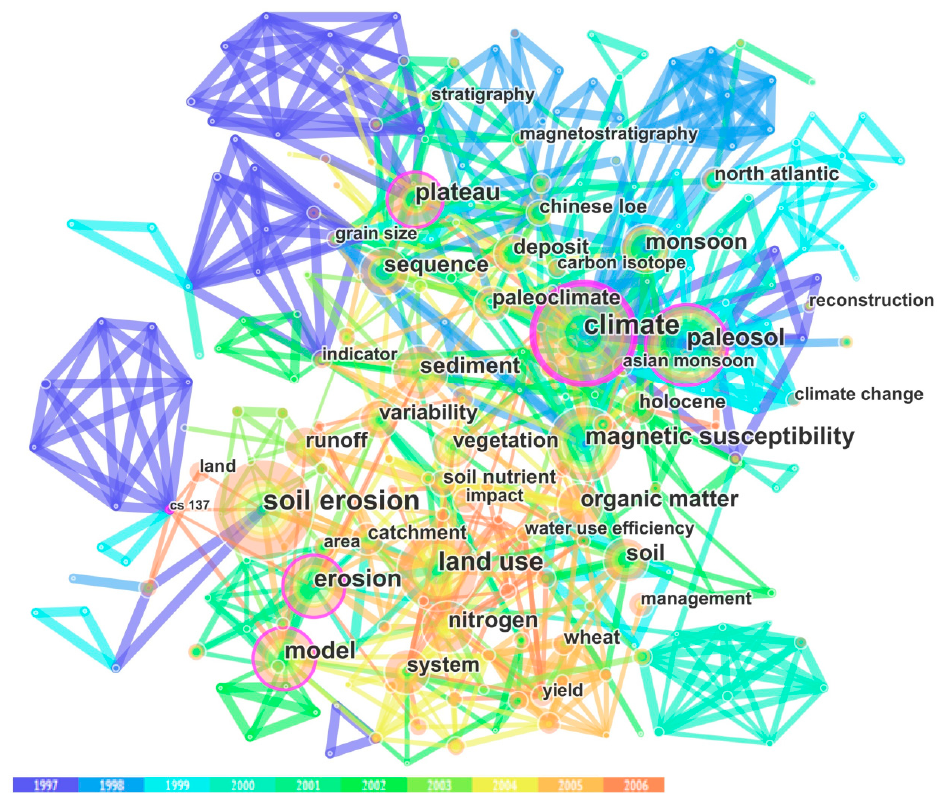
Figure 3. The bibliometric network map of keywords based on SCI literature from 1997–2006. Table 2. Annual distribution of the main research topics of CNKI literature from 1997–2006.